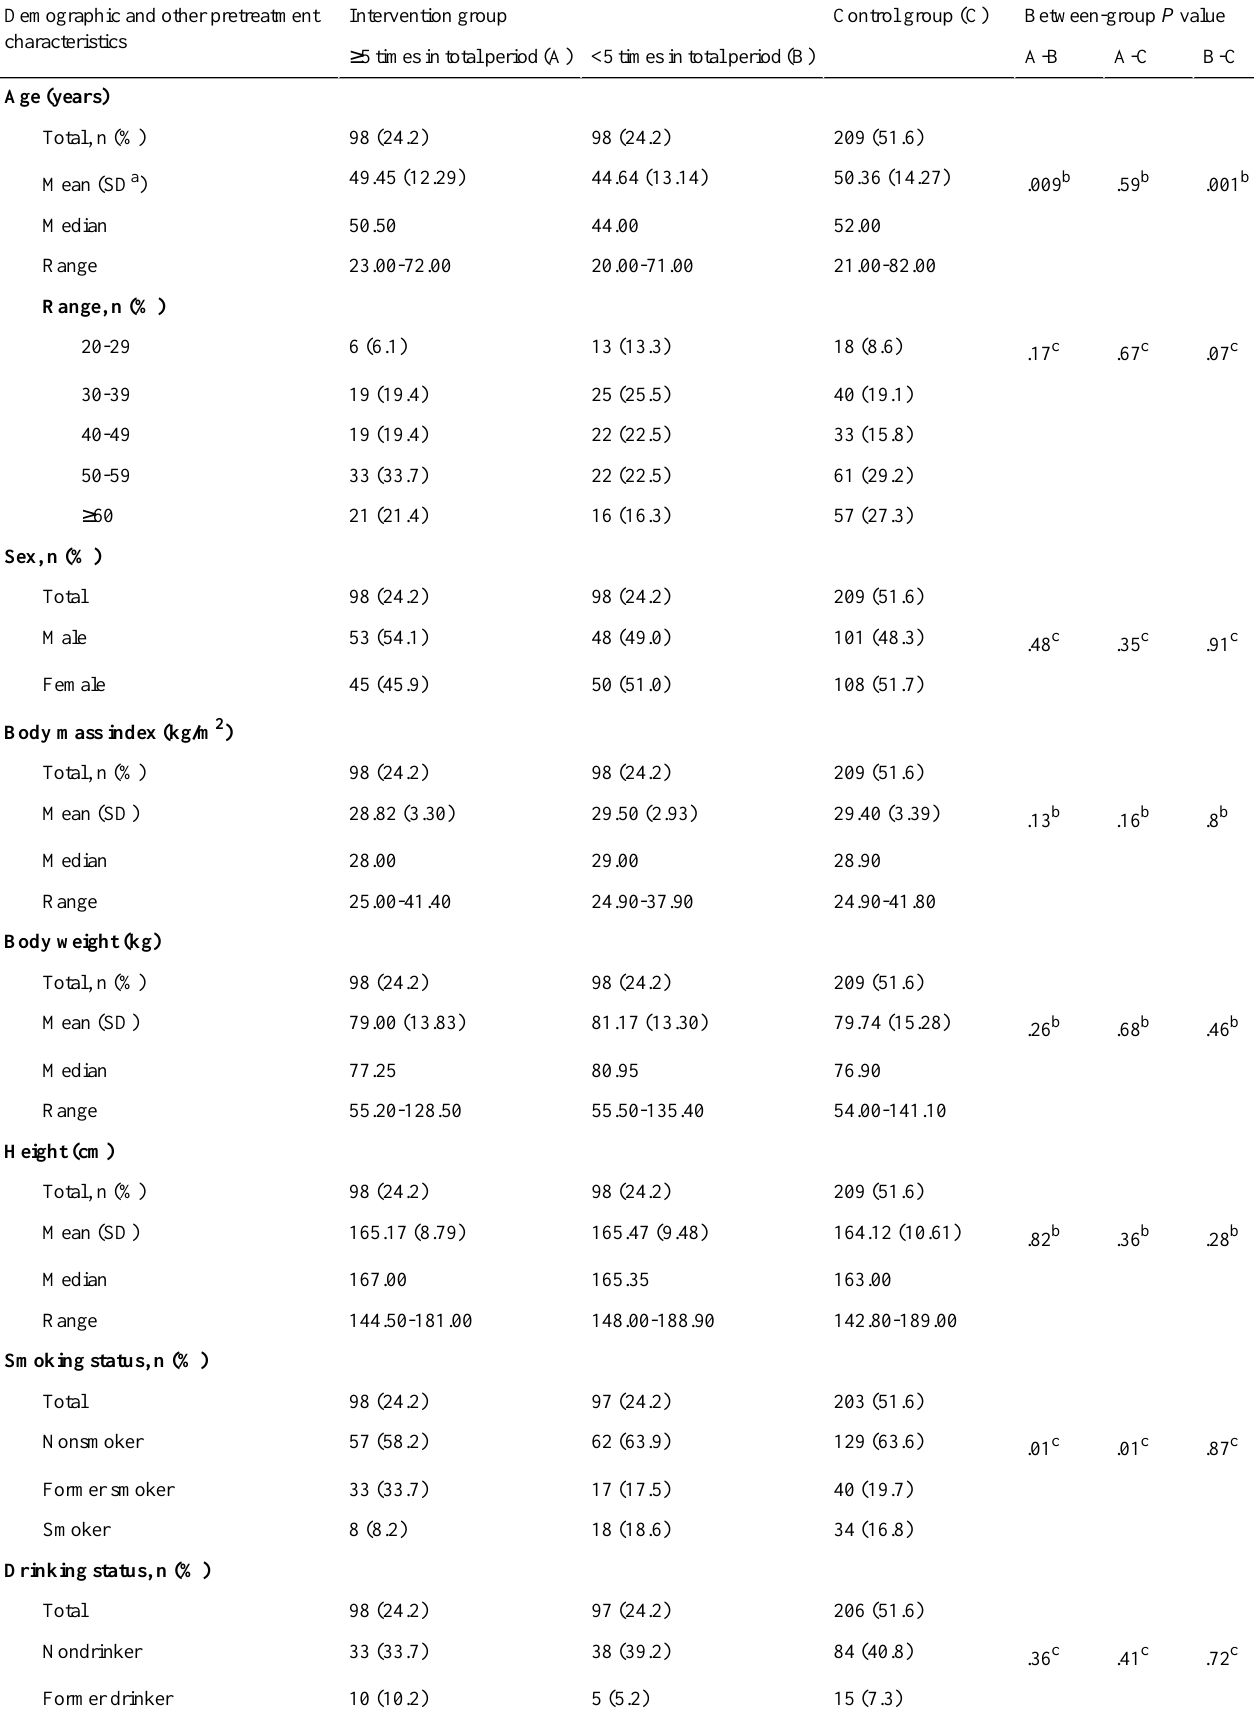
Table 2. Demographic and other pretreatment characteristics (intention-to-treat set) by total number of health consultations (n=405).